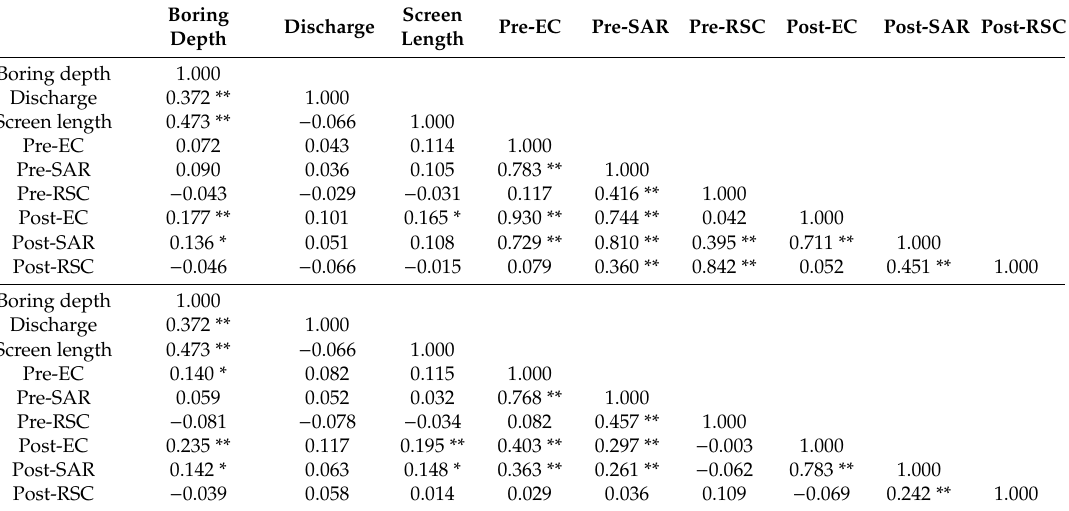
Table 4. Spearman’s rank correlation matrix for groundwater quality